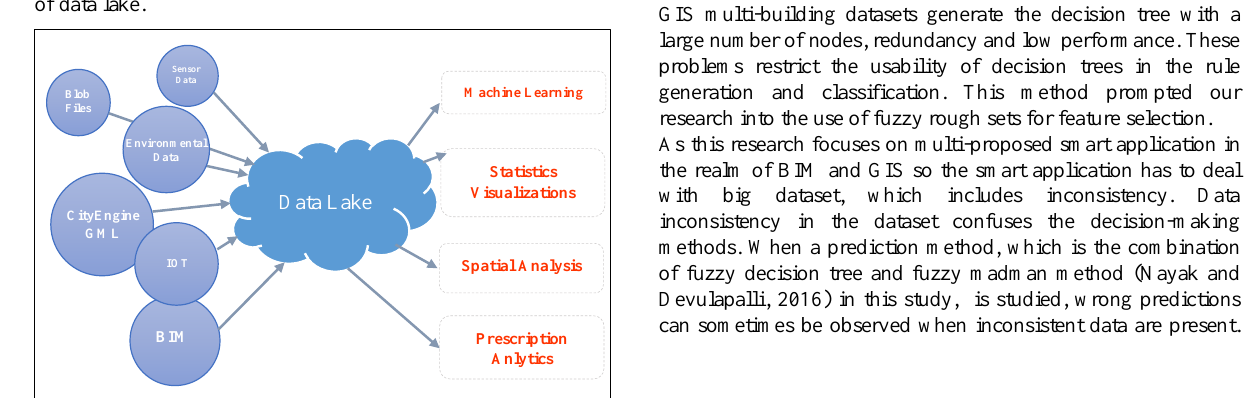
Figure 1. Data Lake